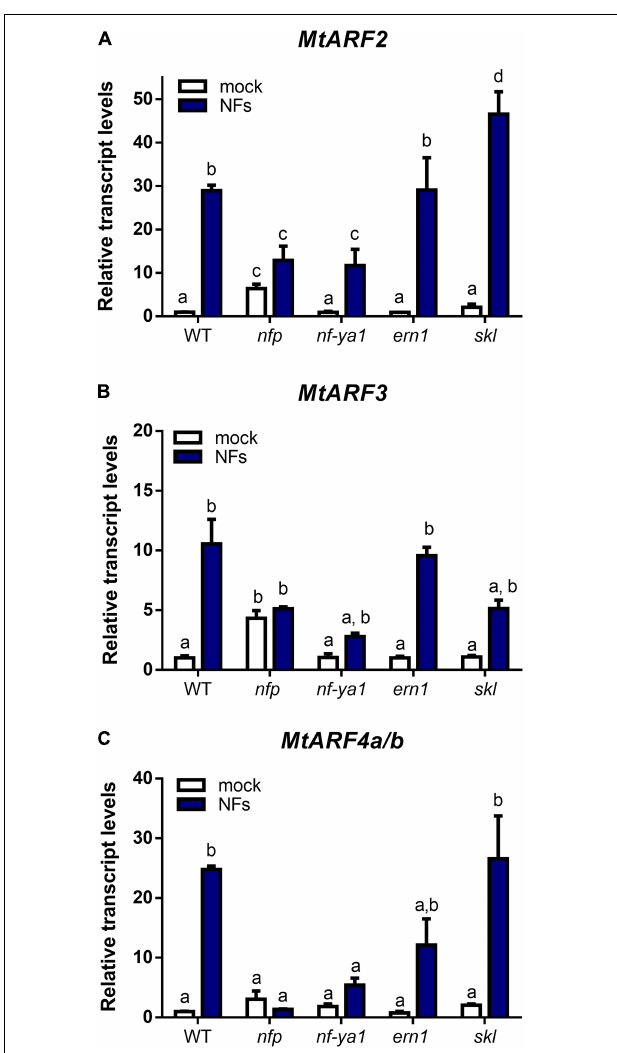
FIGURE 3 | MtARF2 , MtARF3 , and MtARF4a/b are up-regulated by Nod Factors and depends on MtNFP and MtNF-YA1 genes. Transcript levels of MtARF2 (A) , MtARF3 (B) , and MtARF4a/b (C) were analyzed in root tissue of WT and nfp, nf-ya1 , ern1 , and skl mutant plants treated with 10 − 8 M purified Nod Factors (NFs, blue bars) or water (mock, white bars) for 48 h. Expression levels were determined by RT-qPCR and normalized to the levels of the MtHIS3L transcript. Values are expressed relative to the WT mock-treated sample, which was set at 1. Different letters above the bars indicate statistically significant differences between samples in an unpaired two-tailed Student’s t test with a p value ≤